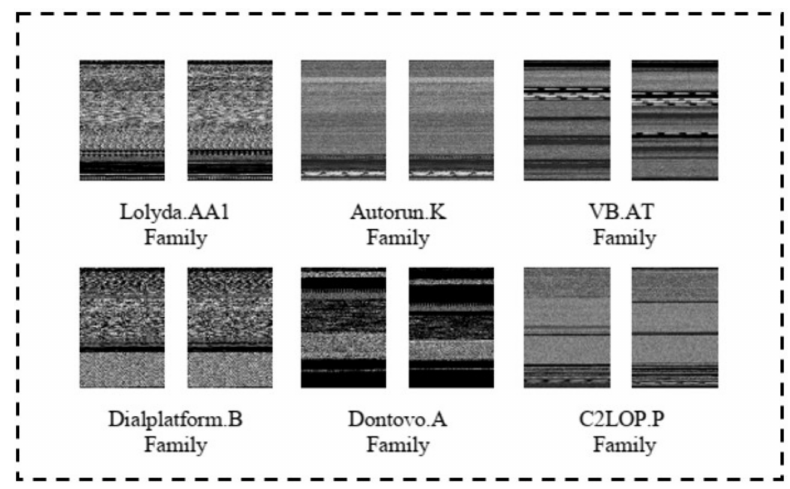
Figure 11. Visual Samples showing Dissimilarity Between the Images of Different Families [51].